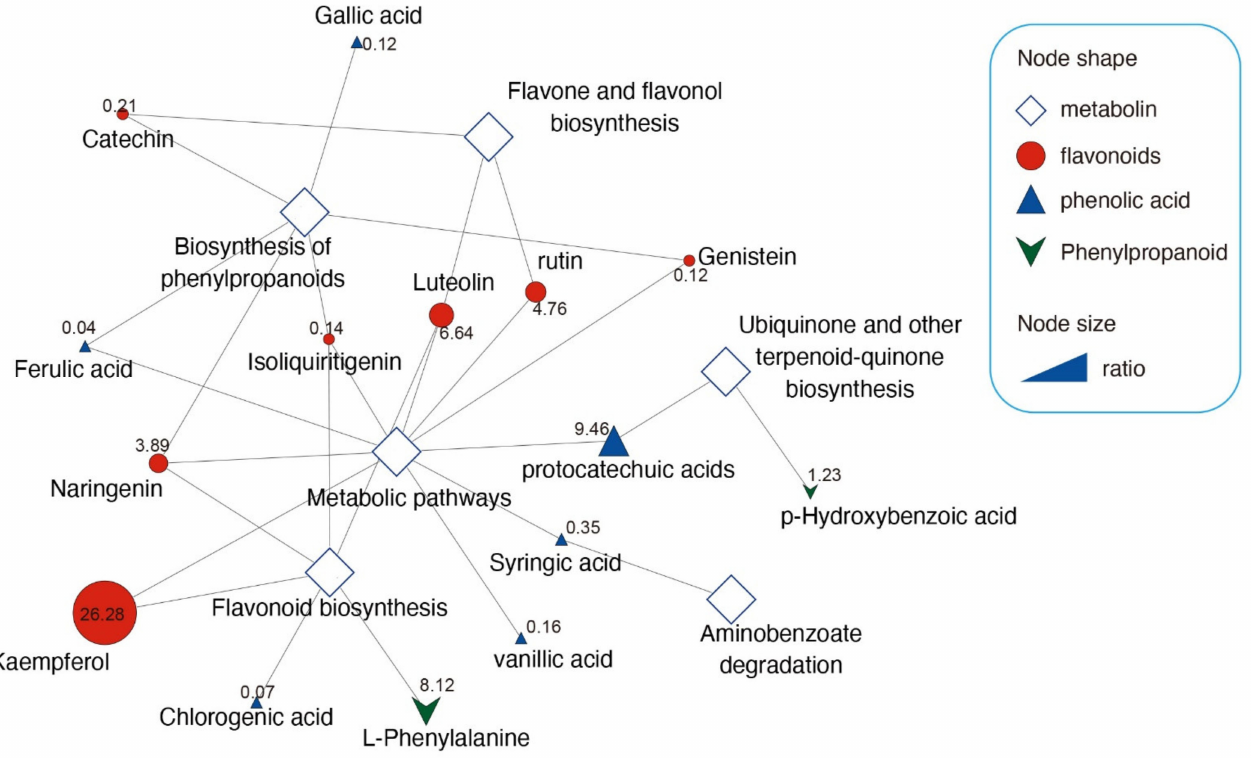
Figure 5. Distribution of the accumulation of phenolic compounds in S. glauca and S. salsa . Metabolites are represented by circles, and related pathways are represented by diamonds. Correlation networks are composed of 15 phenolic compounds. Metabolites from the merged dataset were mapped to the KEGG and MBRole reference pathways, and interaction networks were generated in Cytoscape ( p < 0.05). For metabolites, colored points represent the ratio of S. glauca to S. salsa , and the number of metabolites is represented by the size of the